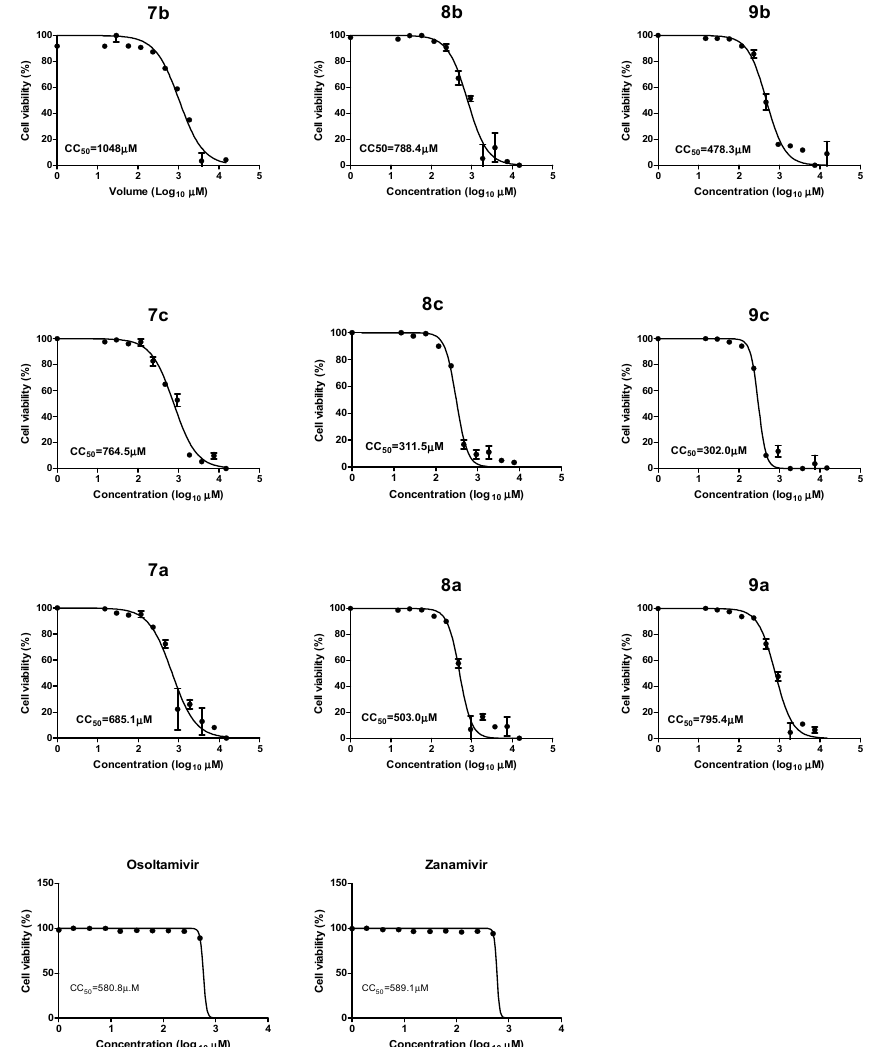
Figure 4. Cytotoxicity assay of new synthetic compounds, oseltamivir, and zanamivir in MDCK cells. The 50% cytotoxic concentration (CC 50 ) of each tested compound was calculated by using nonlinear regression analysis (GraphPad Prism software).